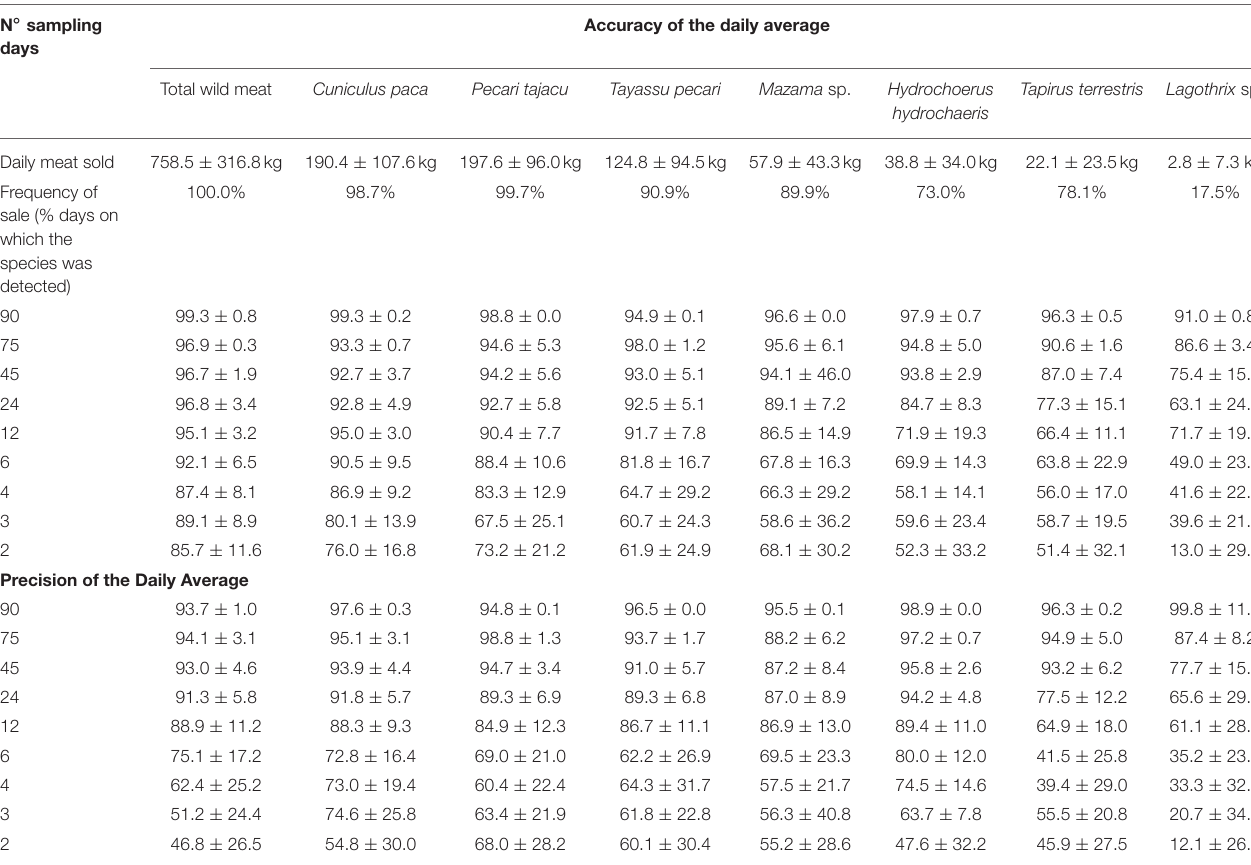
TABLE 1 | Accuracy and precision (in %) of the daily amount of wild meat sold according to different experimental efforts in two 12-month surveys conducted in 2006–2007 and 2017–2018. N ◦